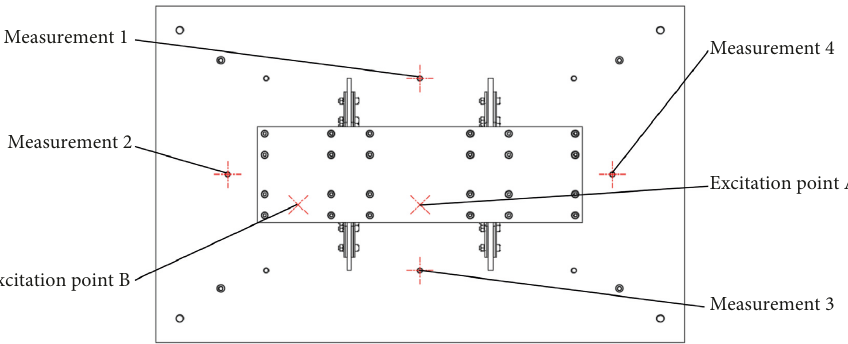
Figure 19: The arrangement of excitation point and measurement points. Table 7: The parameters of the excitation signal.